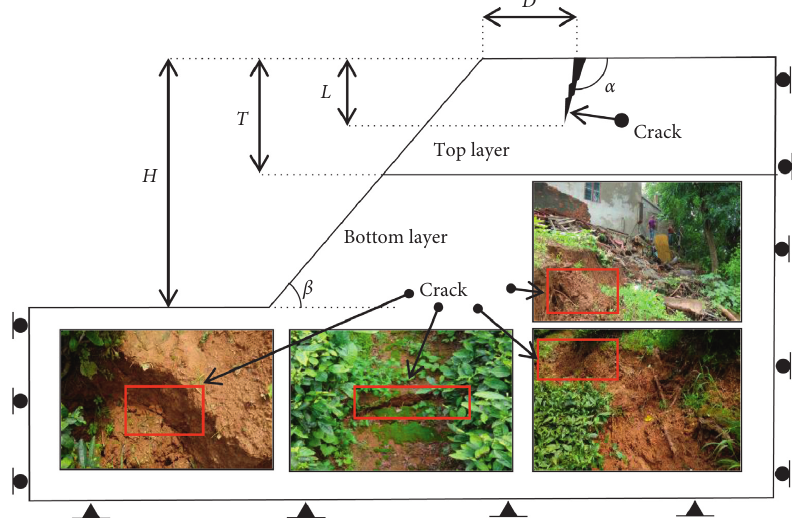
Figure 1: Definition of two-layered slope with